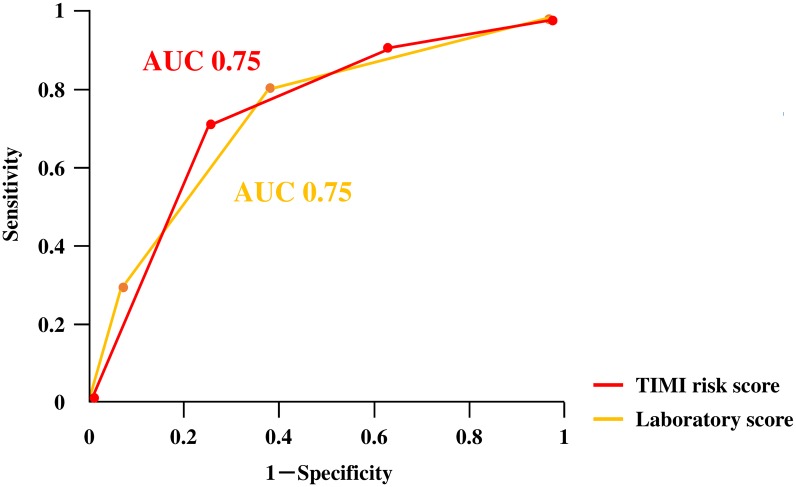
ROC curve of the laboratory model and the TIMI risk index in all STEMI cases.AUC, area under the curve.